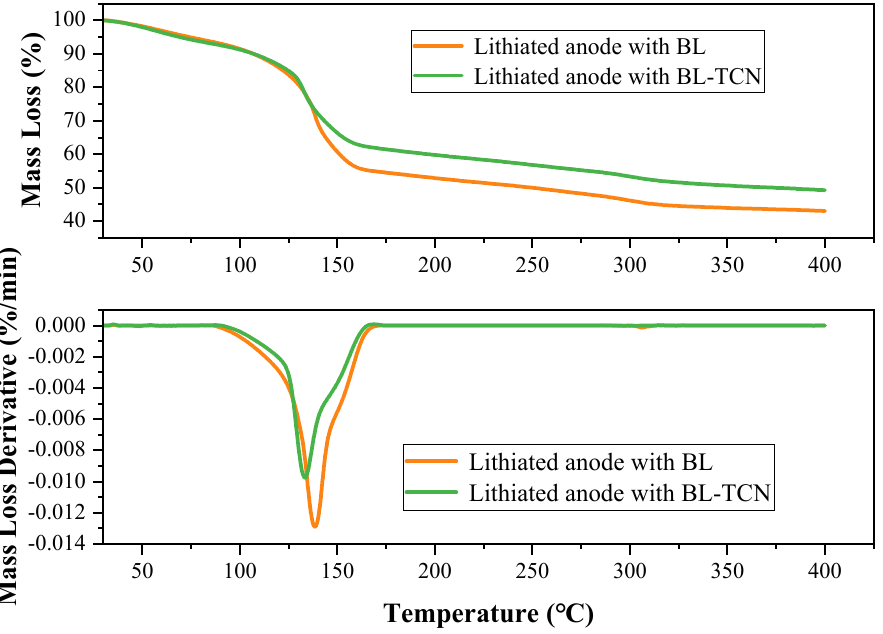
Figure 5. TG-DTG curves of lithiated anode with different electrolytes at a rate of 6 °C/min. The mass loss of the sample without the additive was 56.93%, while the mass loss of the sample with the additive TCN was decreased to 49.98% when comparing the two sets of data with different electrolytes. The reaction of the lithiated anode with the BL-TCN electrolyte was slower and the reaction time was shorter, particularly in the third stage of mass loss. The TG results showed that additive TCN positively inhibited the exothermic reaction between the lithiated anode and electrolyte, which was consistent with the DSC results.